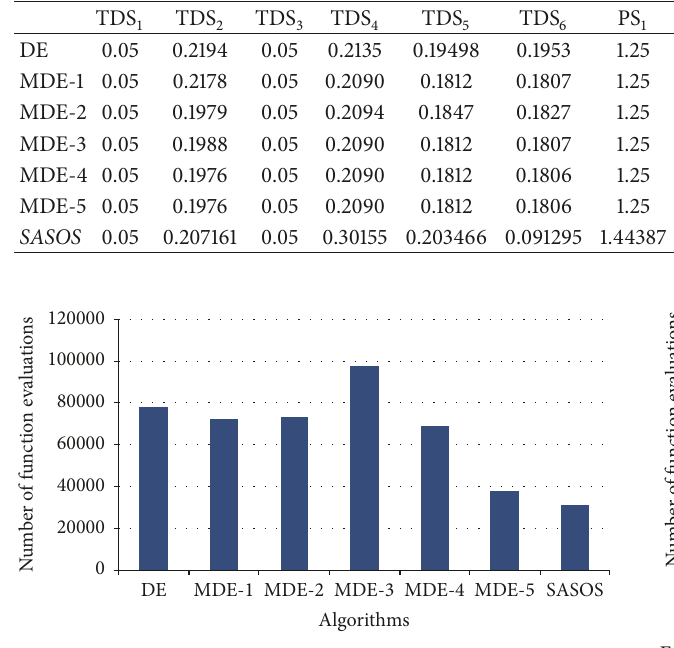
Figure 4: Comparison of number of function evaluations done, for obtaining the best results, by SASOS algorithm with DE and its modified versions for 3-bus model.